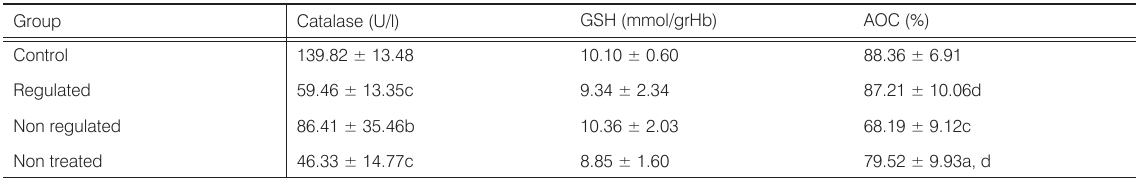
Table 3. Catalase activity, GSH level and total antioxidative capacity in plasma and blood of normotensive and hypertensive patients.